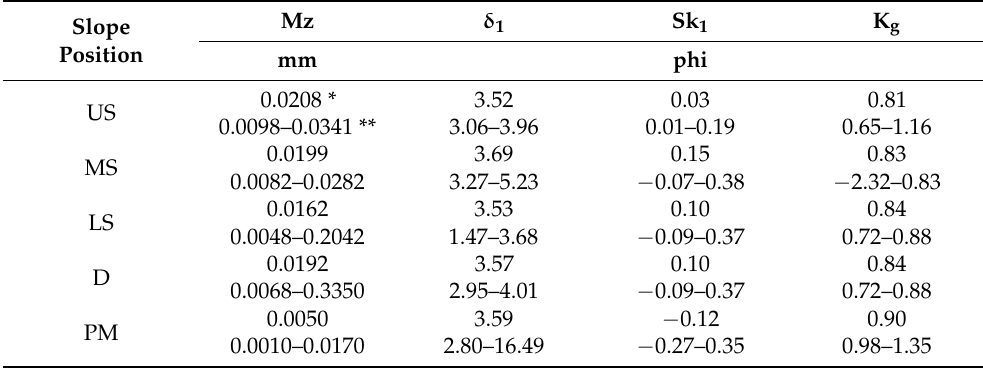
Table 6. Sedimentological indices in humus horizons and parent material in ice-dammed lakes landscape, regarding the soil position at the